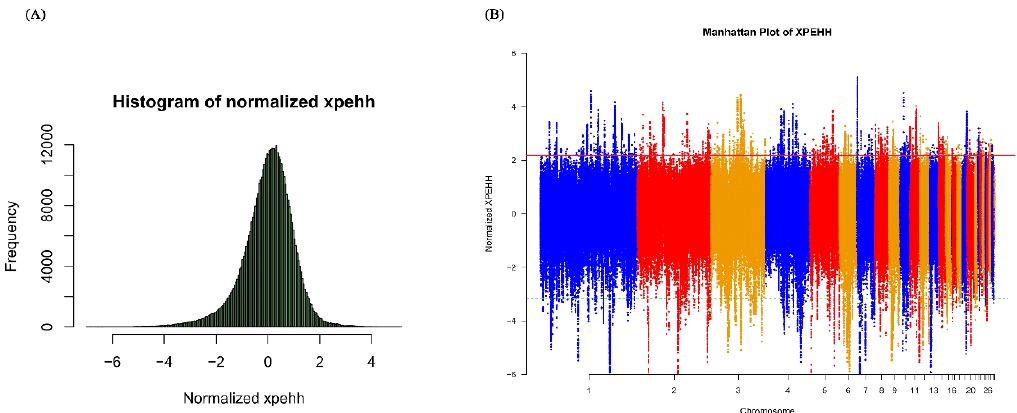
Figure 1. The distribution of cross population extended haplotype homozygosity (XPEHH) scores. ( A ) Histogram of normalized XPEHH; ( B ) XPEHH scores along autosomes. Unusually positive XPEHH scores suggest signatures of positive selection in the Tibet chicken genome. The red line shows the p value threshold of 0.01 (XPEHH score > 2.186052).